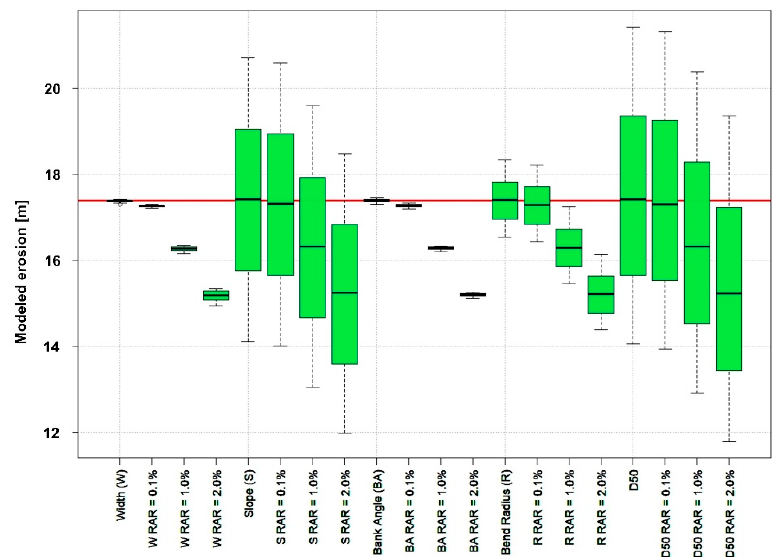
Figure 7. Sensitivity analysis using the data for the Selwyn / Waikirikiri River catchment. For every input parameter, the values varied +/ − 10% from the original input value. The red line is the reference for the modeled erosion = 17.40 m using the original input values. Each boxplot represents the quantile of the cumulative erosion.